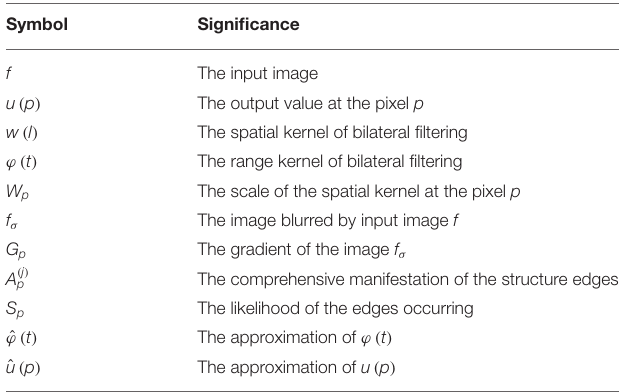
Necessary symbols. Algorithm 1 | Structure-preserving bilateral texture